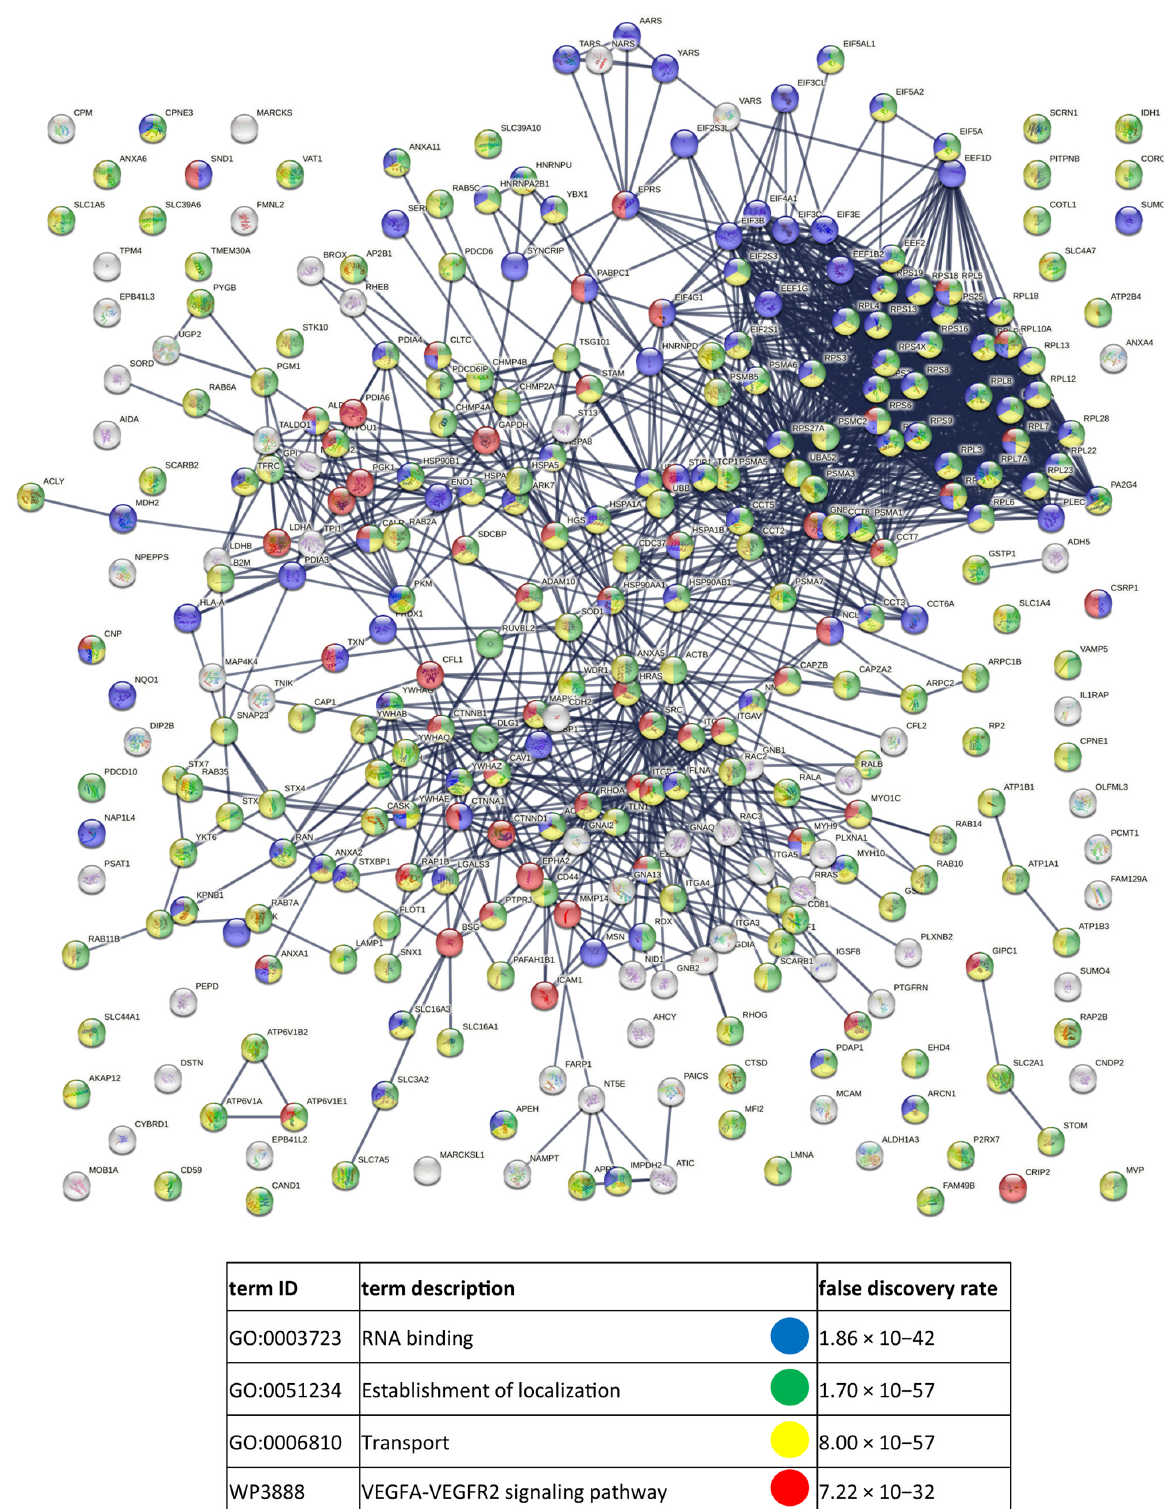
Figure A12. Diagram of functional protein association networks prepared with the use of STRING v. 11.0 software for proteins upregulated in WM115-derived exosomes vs. WM266-4-derived exosomes. The selected, strongly represented pathways are presented as an interactome. Proteins with fold change > 1.2 were considered upregulated in WM266-4 cells ( p < 0.05). A complete analysis is presented in Supplementary Data